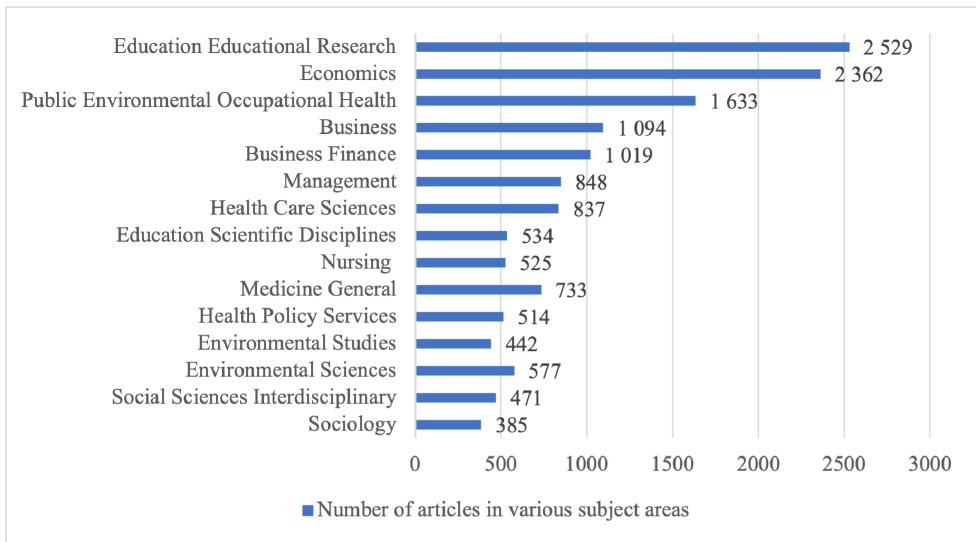
Figure 3. Top research areas with more than eight published articles on financial literacy retrieved from